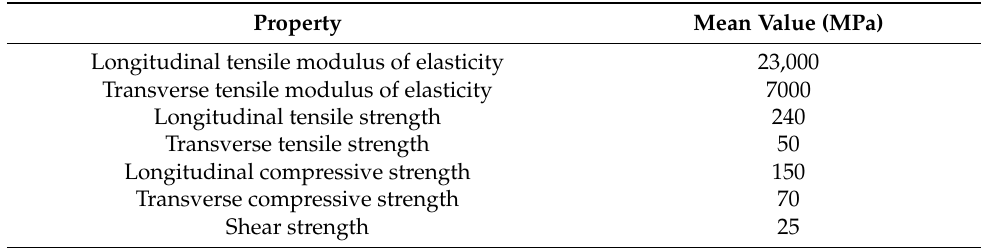
Table 1. Mechanical properties of pultruded GFRP.